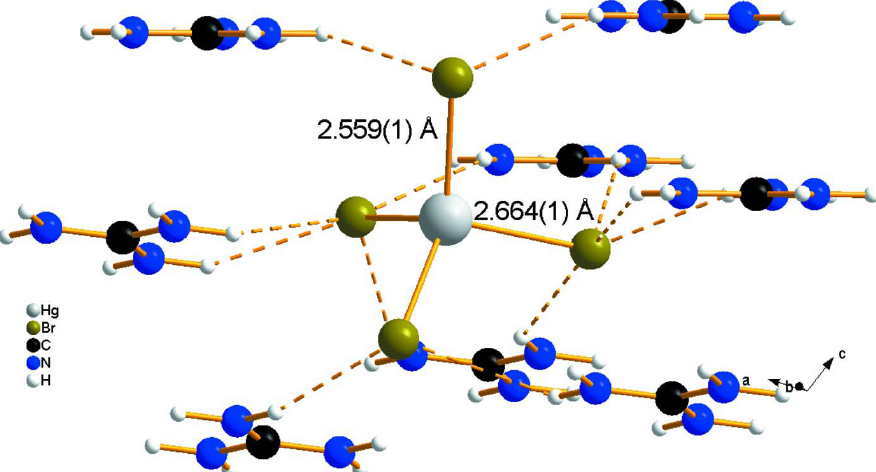
Figure 2 Connection scheme of the HgBr